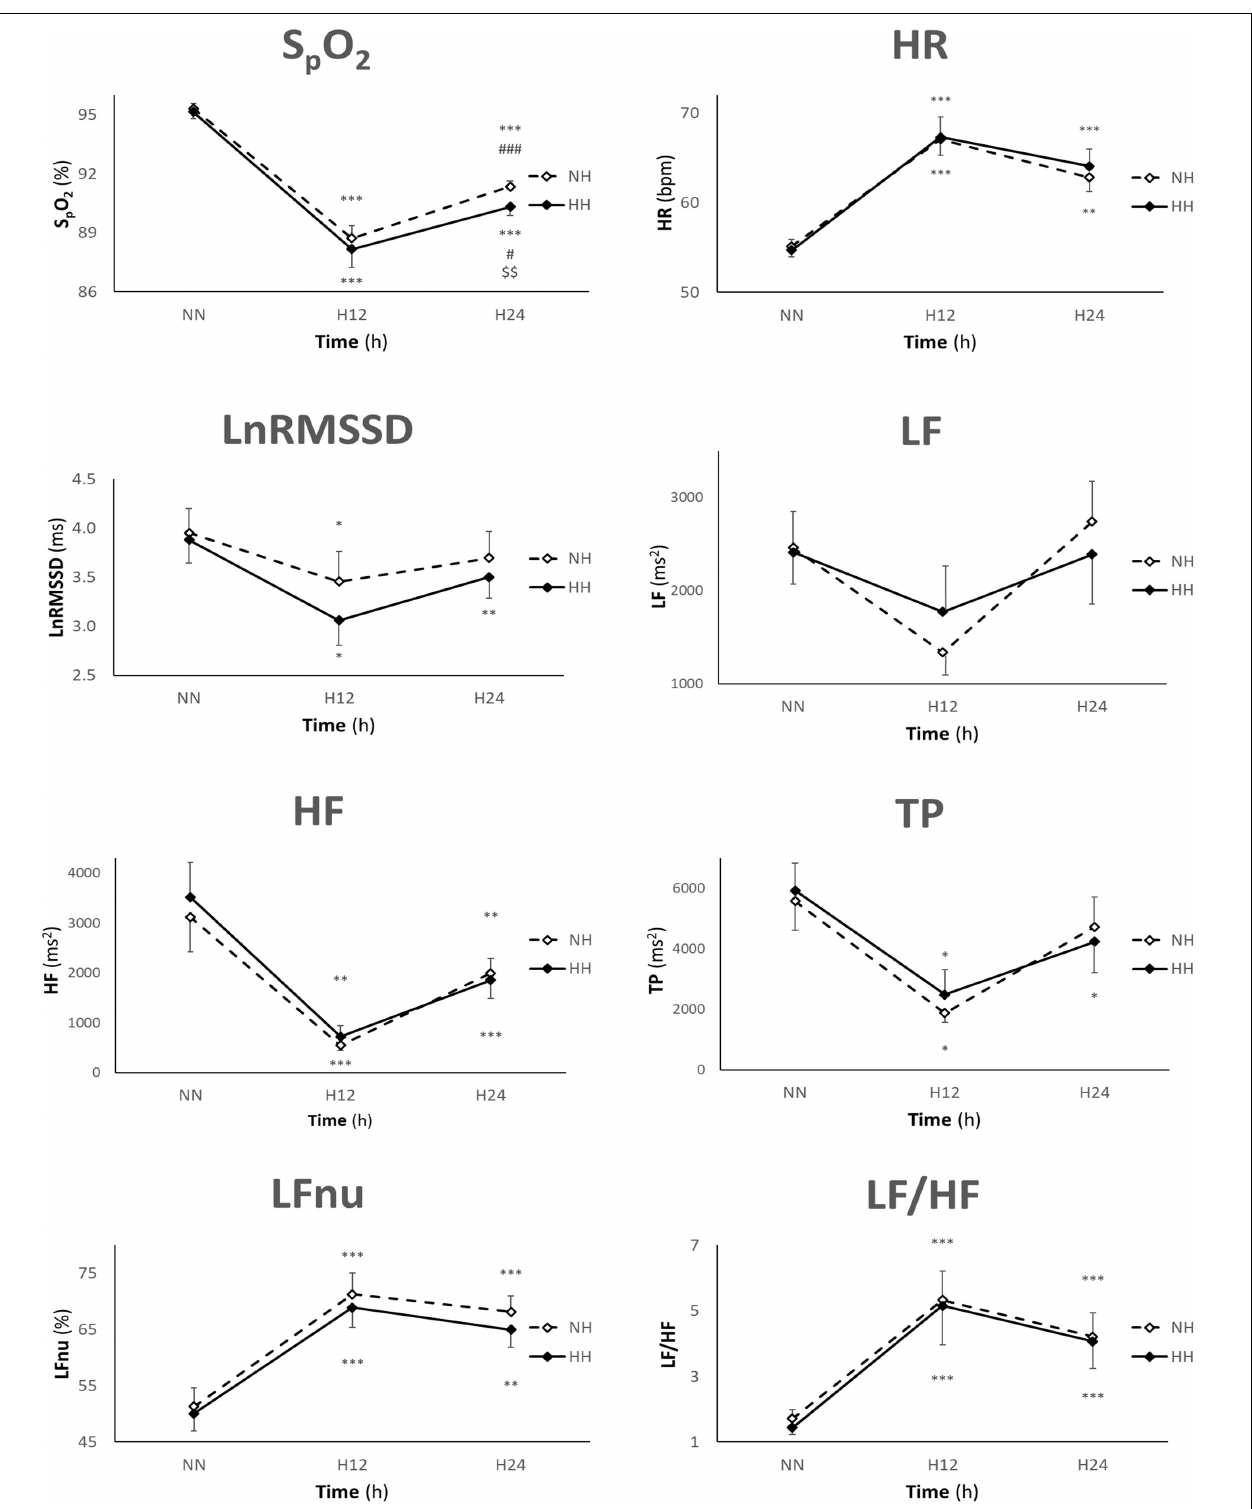
Frontiers in Neuroscience |